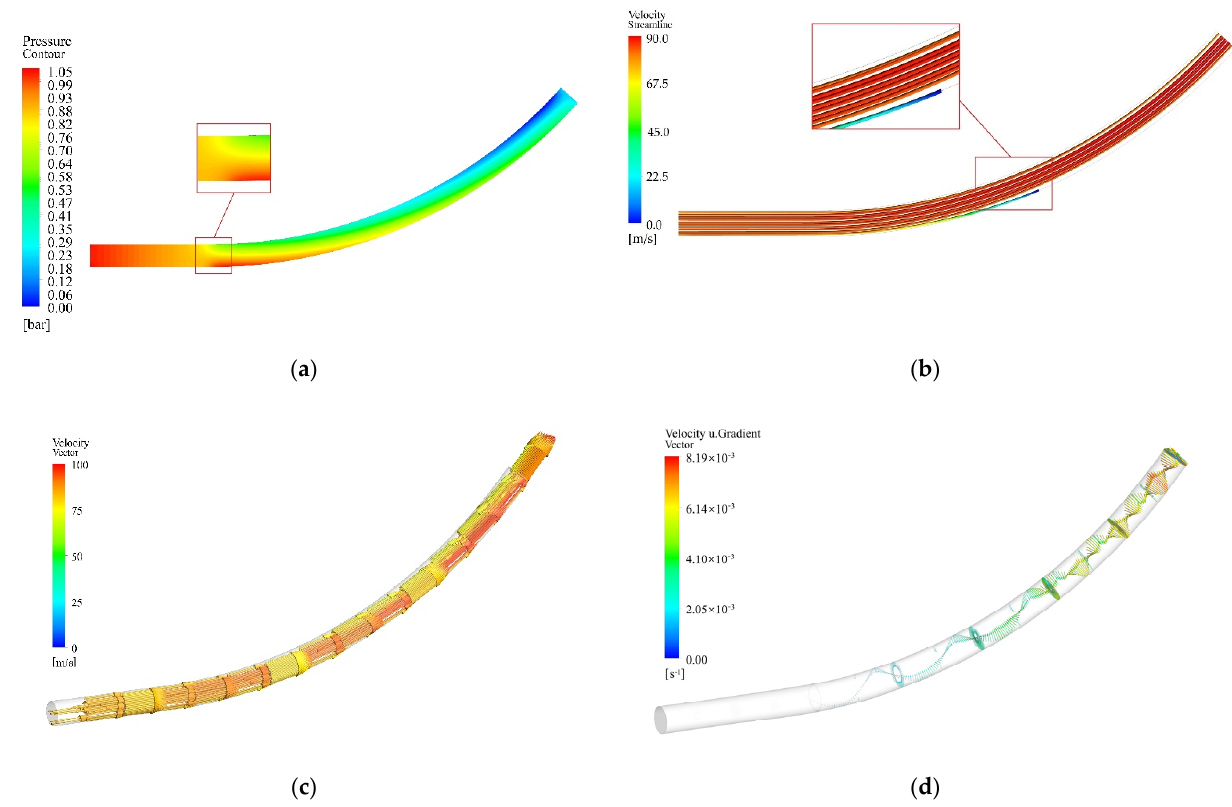
Figure 8. Flow characteristics results of the 1D–3D approach numerical analysis for the exhaust system with a bent pipe shape: ( a ) pressure contour; ( b ) streamline; ( c ) velocity vector; and ( d ) velocity u gradient.